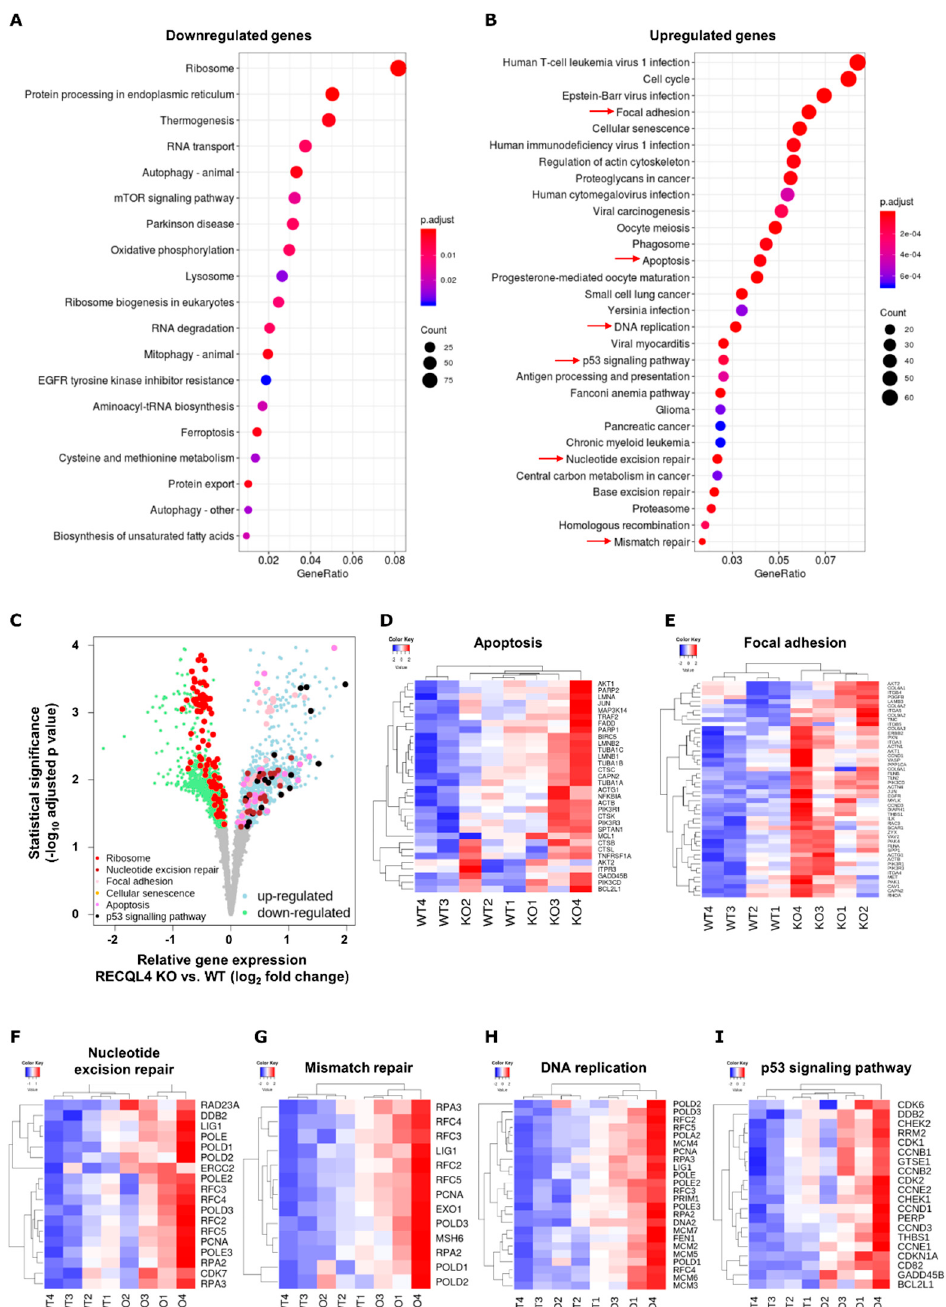
Figure 3. RNA-seq reveals gross transcriptomic changes in RECQL4-depleted glioma cells. Total RNA from WT and RECQL4 KO#2 glioma cells were subjected to RNA sequencing. KEGG analysis of DE genes (FDR corrected p < 0.05) shows genes / pathways downregulated ( A ) or upregulated ( B ) in RECQ4 KO cells when compared to WT cells. ( C ) Volcano plot shows down- and upregulated genes (log 2 fold change < 0 and log 2 fold change > 0, respectively, and FDR-correction p < 0.05) in RECQ4 KO cell lines relative to the WT. Genes from selected functional KEGG categories ( q -value < 0.05) as marked by red arrows on panel ( B ) are marked in di ff erent colours, as indicated in the legend in bottom left of the panel ( C ). Selected KEGG pathways are also presented on z-score heatmaps: apoptosis ( D ) focal adhesion ( E ) nucleotide excision repair ( F ) mismatch repair ( G ) DNA replication ( H ) and p53 signalling pathway ( I ).